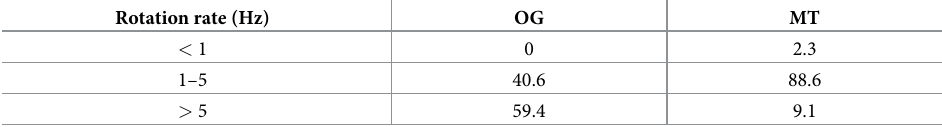
Table 1. Motility of the original (OG) and mutant (MT) strains under the phase-contrast microscopic observation.